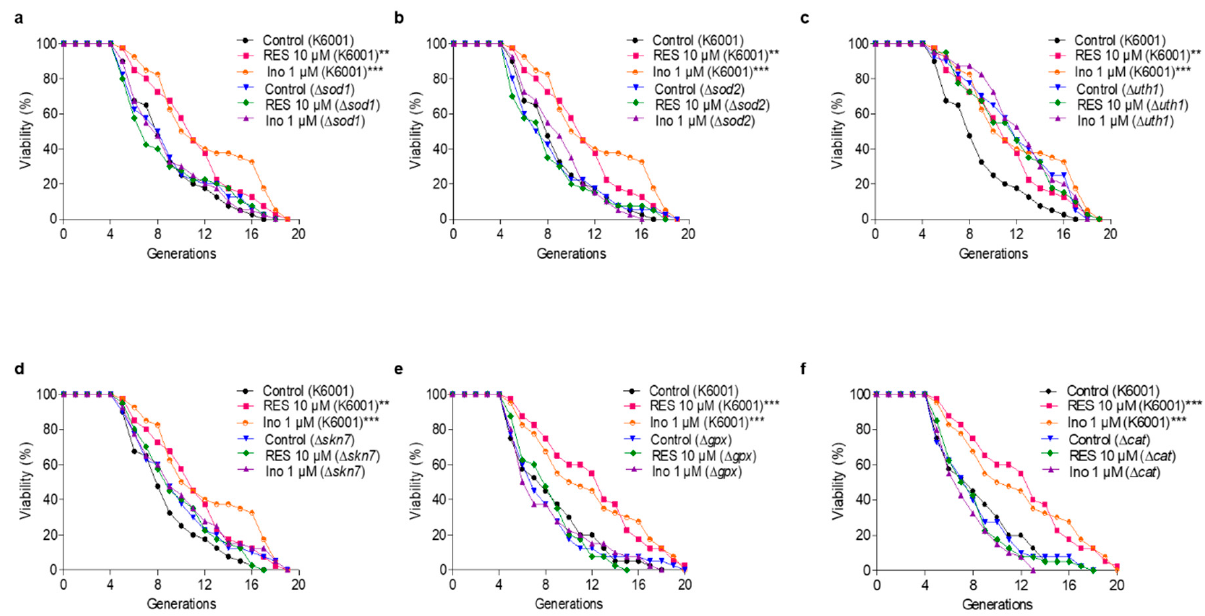
Figure 4. Effect of inokosterone on the replicative lifespan of ∆ sod1 ( a ), ∆ sod2 ( b ), ∆ uth1 ( c ), ∆ skn7 ( d ), ∆ gpx ( e ) and ∆ cat ( f ) yeasts with a K6001 background. In the lifespan assay of ∆ sod1 , ∆ sod2 , ∆ uth1 and ∆ skn7 , the average lifespan of K6001 in the control group was 7.93 ± 0.51, whereas those of RES at 10 µ M and inokosterone at 1 µ M were 10.20 ± 0.59 ( p < 0.01) and 11.18 ± 0.70 ( p < 0.001), respectively. ( a ) The average lifespan of ∆ sod1 in the control group was 7.93 ± 0.57, whereas those of RES at 10 µ M and inokosterone at 1 µ M were 7.78 ± 0.64 and 8.05 ± 0.56, respectively. ( b ) The average lifespan of ∆ sod2 in the control group was 7.53 ± 0.56, whereas those of RES at 10 µ M and inokosterone at 1 µ M were 7.33 ± 0.57 and 8.23 ± 0.47, respectively. ( c ) The average lifespan of ∆ uth1 in the control group was 10.88 ± 0.60, whereas those of RES at 10 µ M and inokosterone at 1 µ M were 10.48 ± 0.67 and 11.50 ± 0.59, respectively. ( d ) The average lifespan of ∆ skn7 in the control group was 8.93 ± 0.63, whereas those of RES at 10 µ M and inokosterone at 1 µ M were 8.93 ± 0.56 and 9.23 ± 0.64, respectively. In the lifespan assay of ∆ gpx and ∆ cat , the average lifespan of K6001 in the control group was 7.55 ± 0.55, whereas those of RES at 10 µ M and inokosterone at 1 µ M were 11.20 ± 0.69 ( p < 0.001) and 10.83 ± 0.78 ( p < 0.001), respectively. ( e ) The average lifespan of ∆ gpx in the control group was 7.18 ± 0.55, whereas those of RES at 10 µ M and inokosterone at 1 µ M were 7.43 ± 0.42 and 7.13 ± 0.57, respectively. ( f ) The average lifespan of ∆ cat in the control group was 7.18 ± 0.50, whereas those of RES at 10 µ M and inokosterone at 1 µ M were 7.18 ± 0.46 and 6.65 ± 0.39, respectively. The experiments were repeated thrice, and the data are presented as the mean ± SEM. ** p < 0.01, and *** p < 0.001 represent significant differences compared with the control